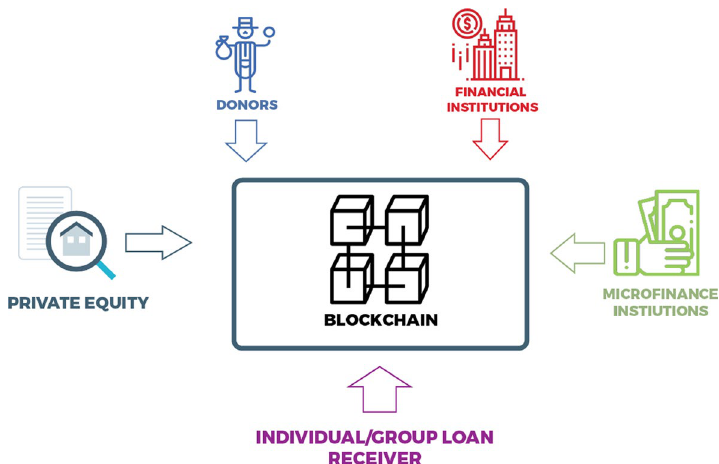
Fig. 2 Proposed blockchain embedded credit system for